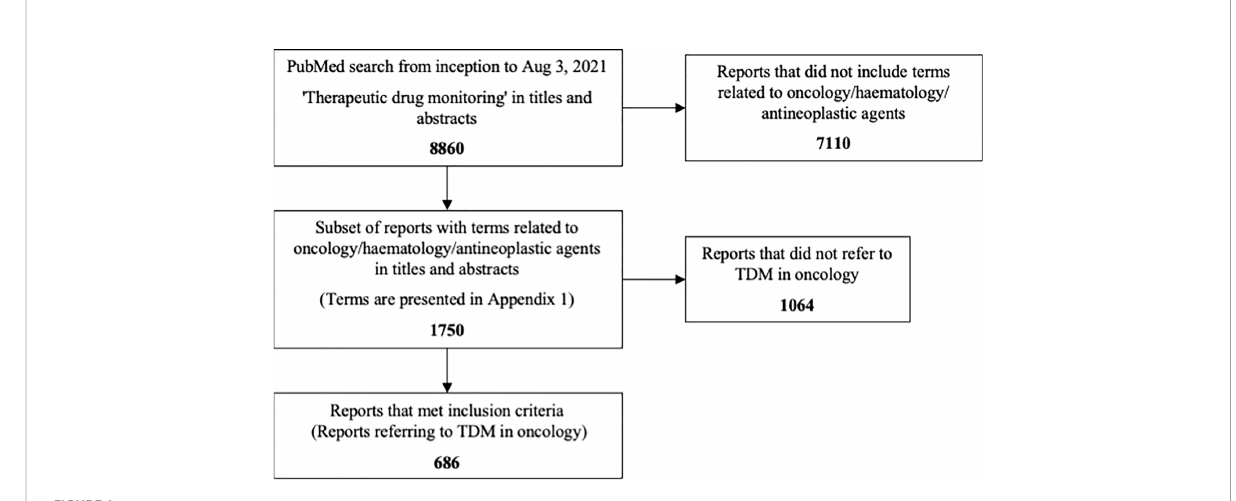
FIGURE 1 Flow chart presenting the study inclusion